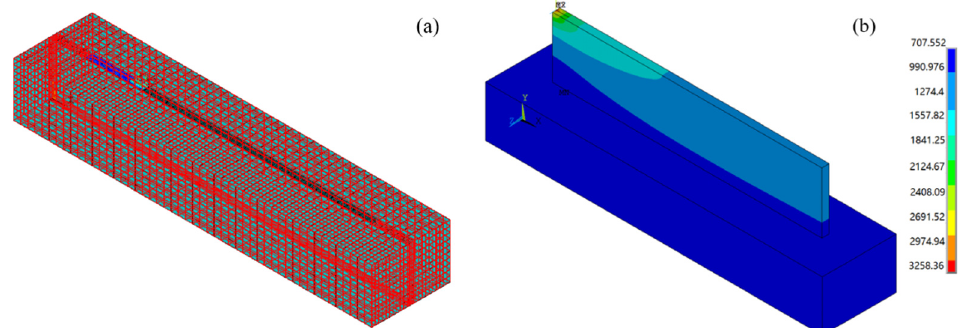
Figure 12. Finite element solution of thin-walled parts formed by laser cladding: ( a ) applying heat flux and loading moving heat source to the first cladding layer; and ( b ) the solution result of temperature field of thin-walled parts at the end of cladding.